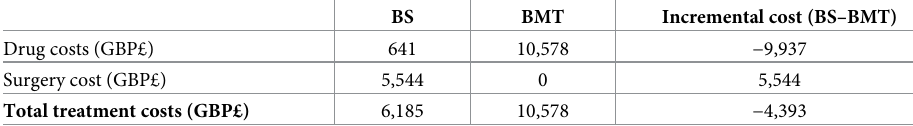
Table 6. Treatment acquisition costs of BS versus